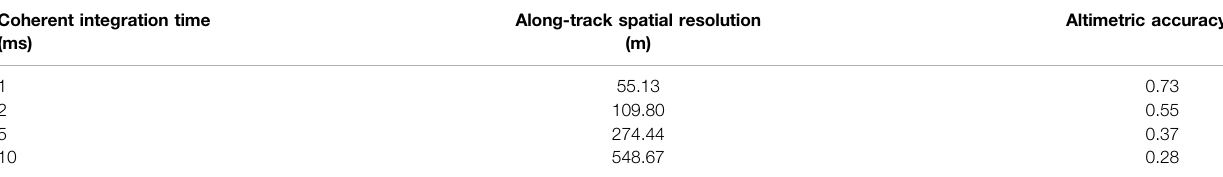
TABLE 2 | The performance of the altimetric accuracy and the along-track spatial